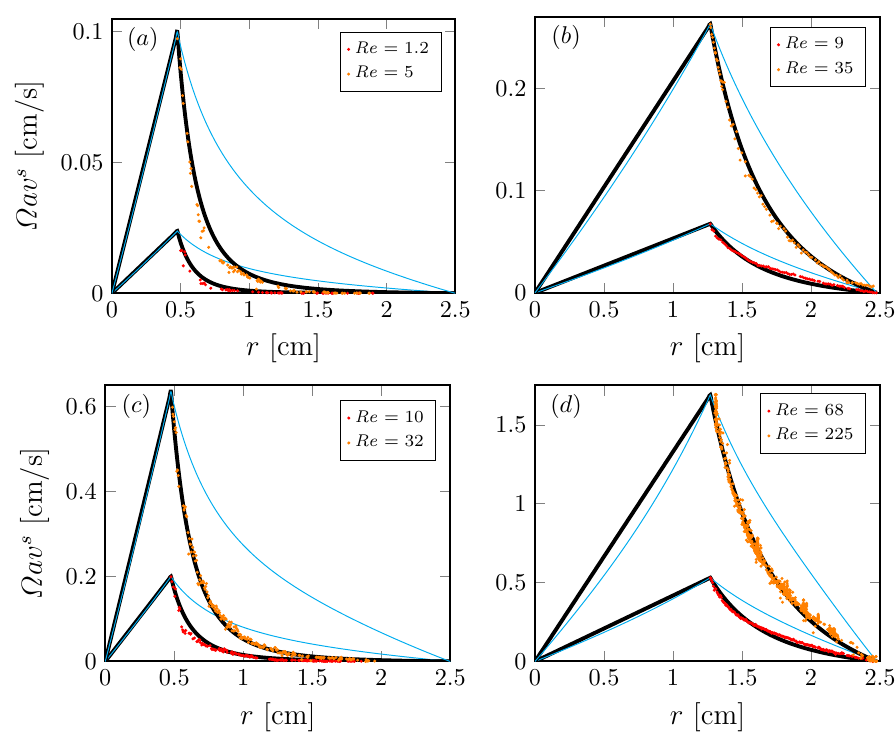
Figure 6. Radial profiles of the azimuthal velocity at the interface in the knife-edge geometry (Figure 5) with with a DPPC monolayer at surface pressure Π = 40mN/m; ( a , c ) are driven by a knife edge of radius a = 0.47cm, ( b , d ) are driven by a knife edge of radius a = 1.27cm, at Reynolds number Re = Ω a 2 / ν as indicated. The symbols correspond to experimental measurements, the thick black lines are the computed velocity profiles with the non-Newtonian model and the thin cyan lines are the computed Newtonian profiles. (Reproduced with permission from [36], published by American Physical Society 2018).